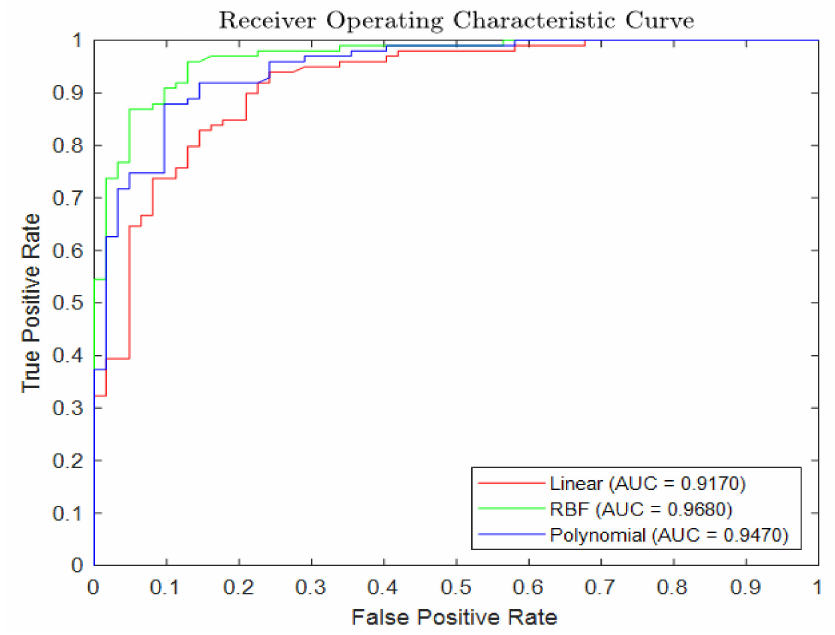
Figure 11. ROC curves of various